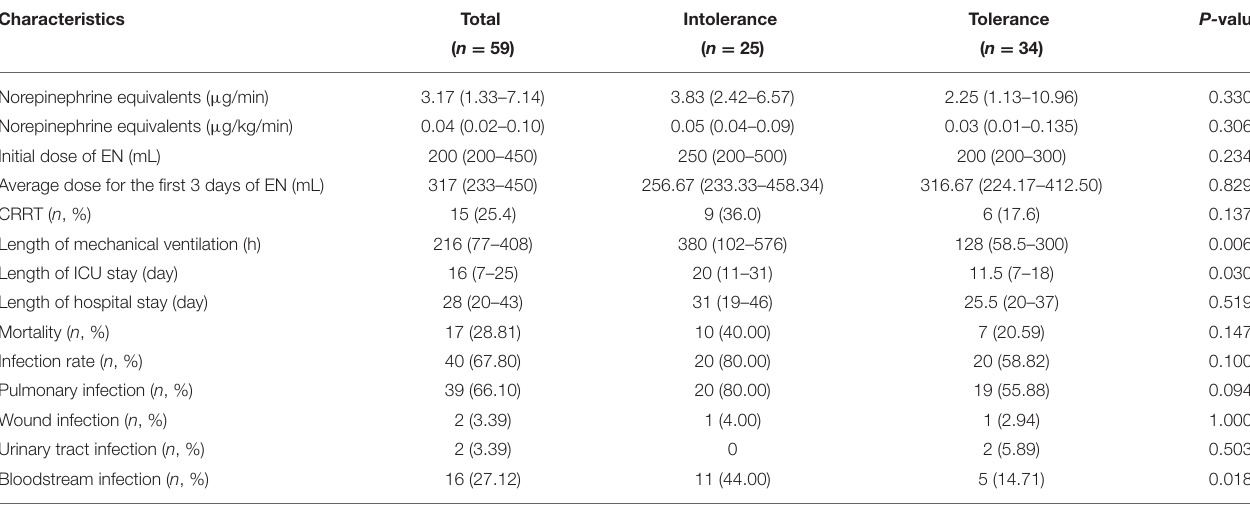
TABLE 2 | The primary and secondary outcomes, grouped by EN intolerance or tolerance.